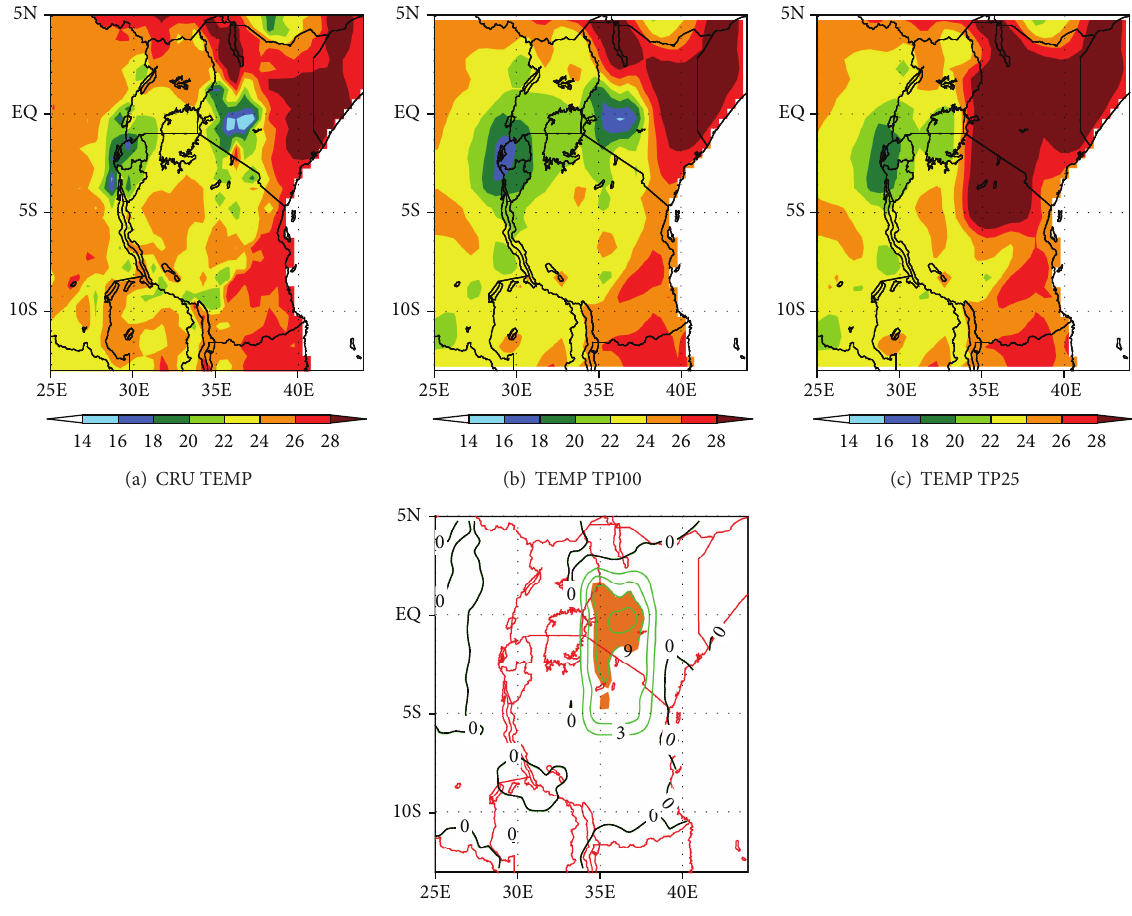
Figure 5: Climatology of OND 2 m temperature (in ∘ C) over the period 2000–2008: (a) CRU observed temperature over land, (b) simulated using actual topography (TP100), (c) simulated using topography reduced to 25% (TP25) over 34 ∘ E–38 ∘ E and 6 ∘ S–2 ∘ N, and (d) temperature difference [(c) minus (b)] with contours (green) at 3 ∘ C interval and the thick (black) contours represent regions over which the temperature difference is zero. The shaded region in (d) is significant at 90% confidence level ( shaded area (orange) indicates a region of significant increase in temperature )